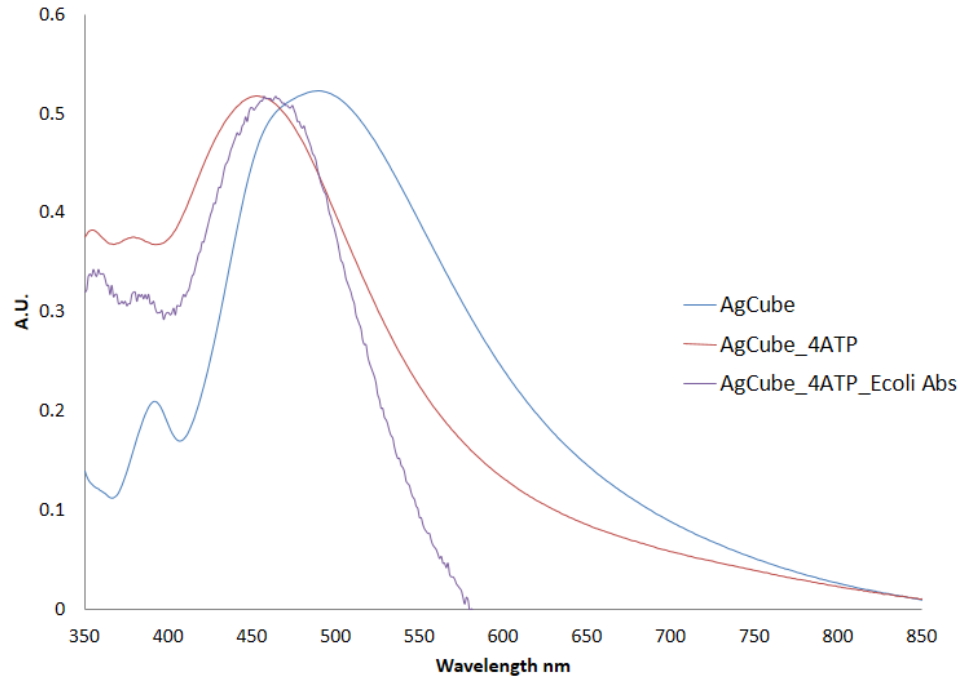
Figure S3. Raman spectra of Ag nanocube with antibodies conjugated to